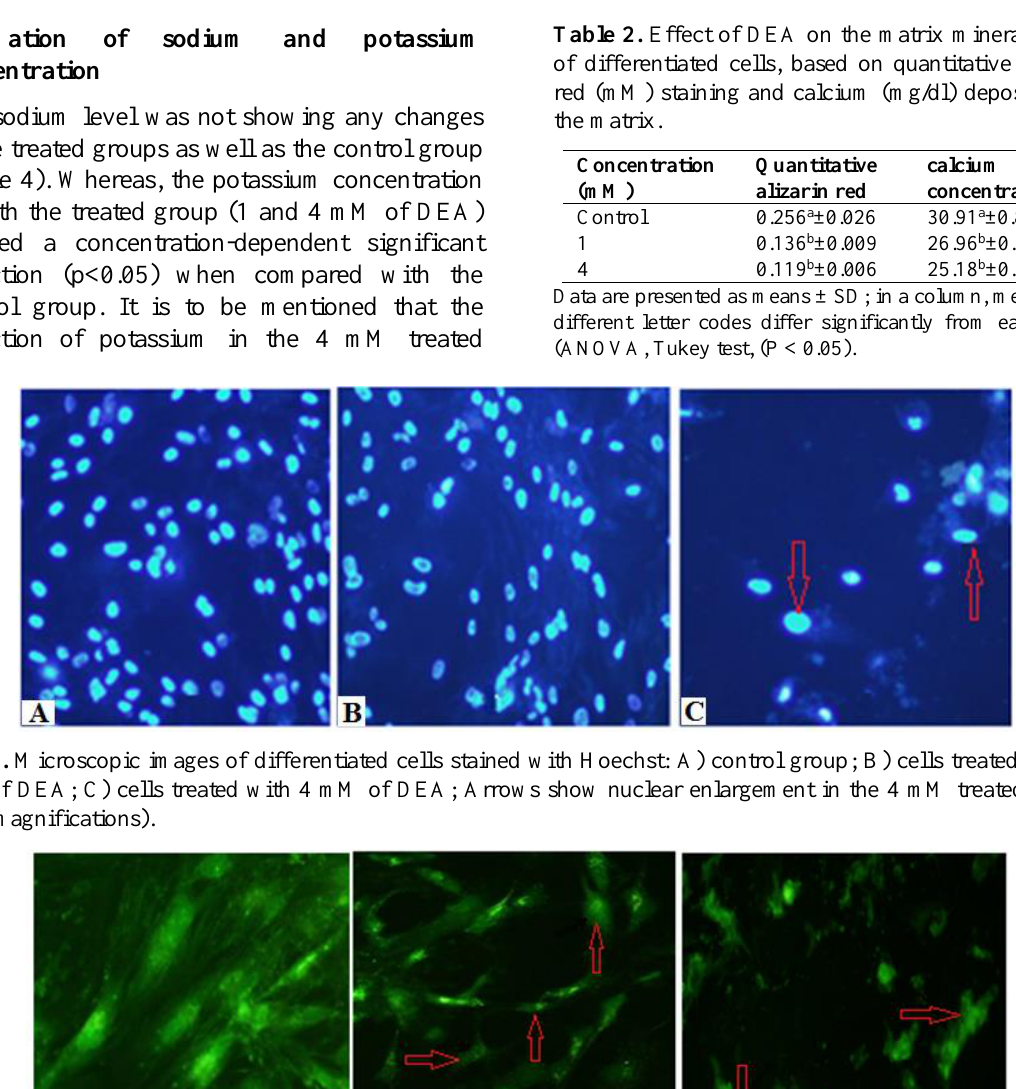
Table 2. Effect of DEA on the matrix mineralization